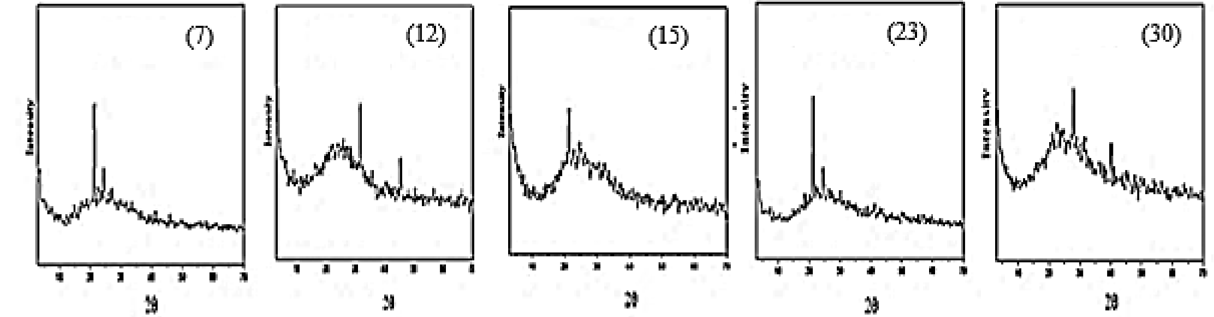
Figure 6. X-ray diffraction patterns of the nano Cr(III) 7, Mn(II) 12, Co(II) 15, Cu(II) 23 and Zn(II) 30